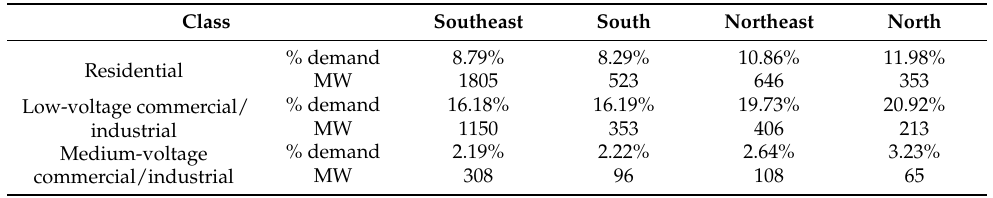
Table 3. Adoption of distributed generation in the current regulation scenario by class and region in